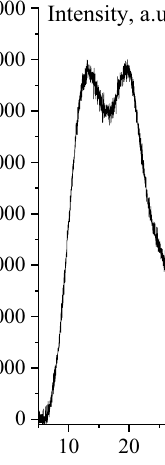
Figure 6. Diffractogram of positive Se NPs sol.